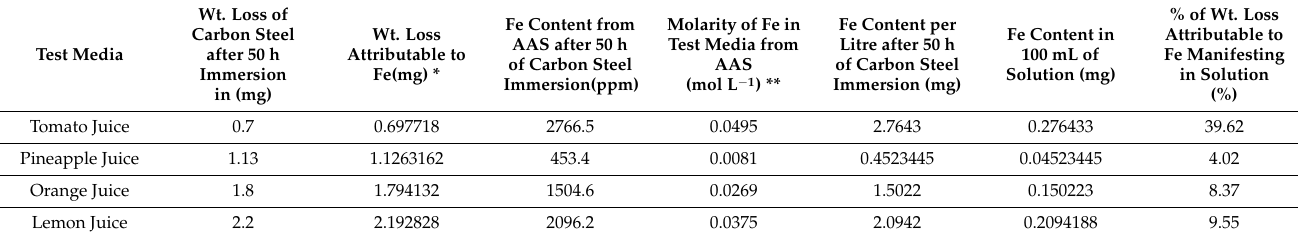
Table 4. Correlation of weight loss and atomic absorption spectrometry results of Fe content in fruit juices after 50 hours’ immersion of carbon steel samples with a surface area of 8.96 cm 2 in 100 mL of test media.